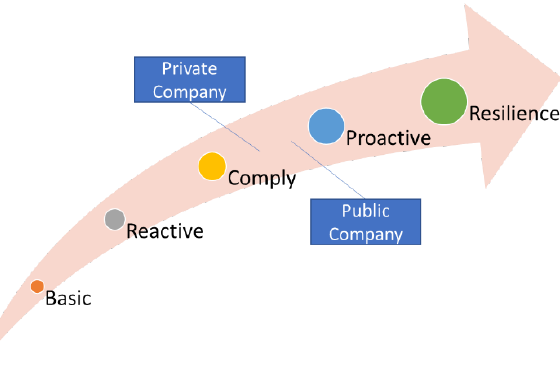
Figure 6. Position of the public and private companies in safety resilience maturity model for the maritime industry.